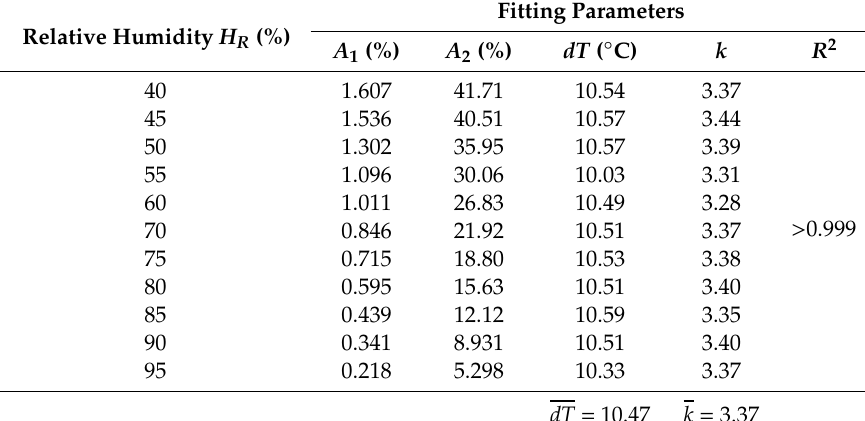
Table 2. Fitting parameters of Equation (2) obtained for the different curves at constant H R . Relative Humidity H R (%)